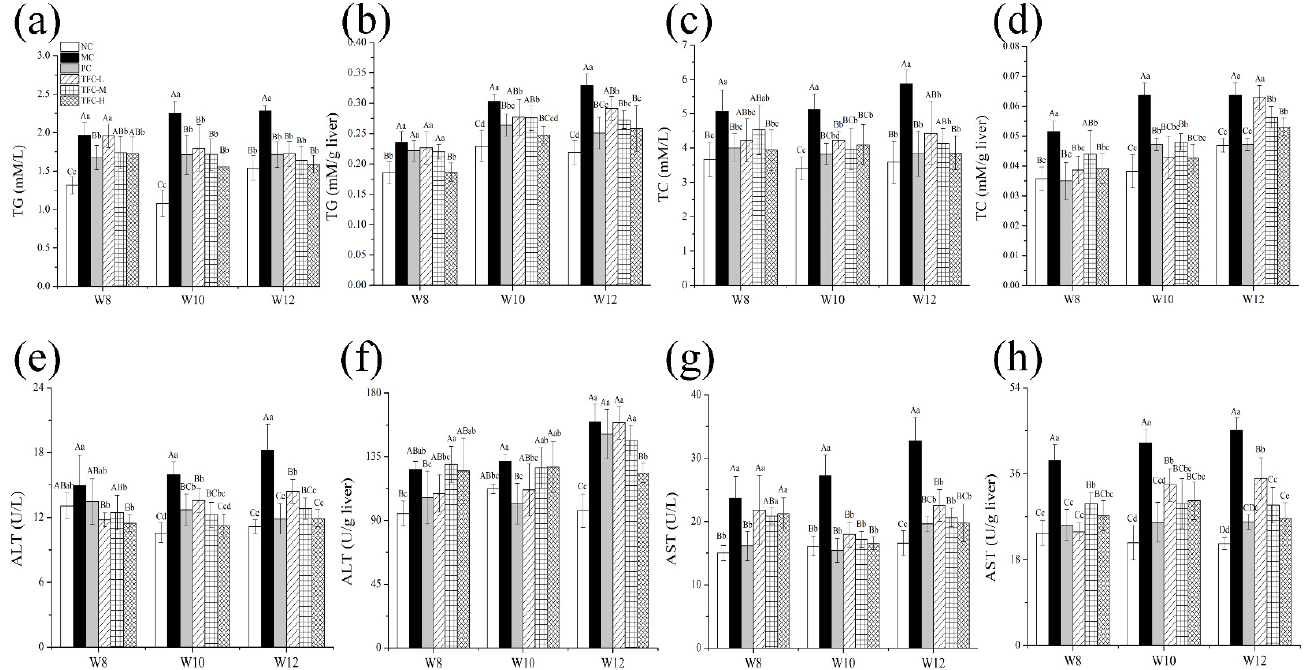
Figure 4. Effects of TFC on lipid metabolism and liver function of NAFLD mice in 8, 10, and 12 weeks: ( a ) serum TG, ( b ) liver TG, ( c ) serum TC, ( d ) liver TC, ( e ) serum ALT, ( f ) liver ALT, ( g ) serum AST, and ( h ) liver AST. Different letters indicate significant differences; abcd p < 0.05, and ABCD p < 0.01.